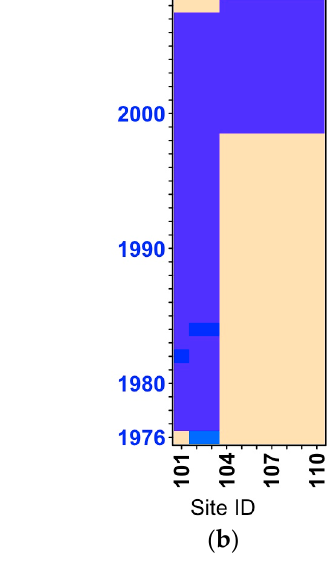
Figure 2. ( a ) Precipitation (81 stations), and ( b ) air temperature (10 stations) in situ data availability at the Lower Mekong Basin. The dark blue color (value of 0 or 0%) refers to a complete data record, while the beige color (value of 1 or 100%) refers to a complete missing data records during a specific year for a specific site.